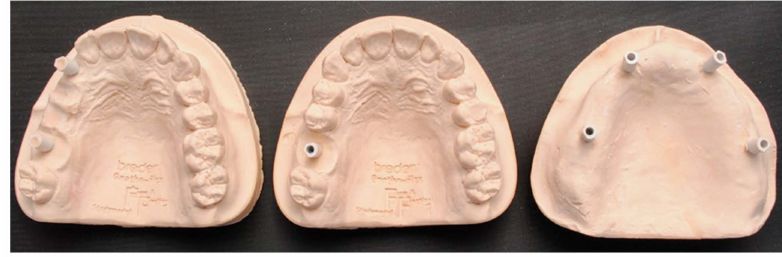
Figure 1. Images of the plaster